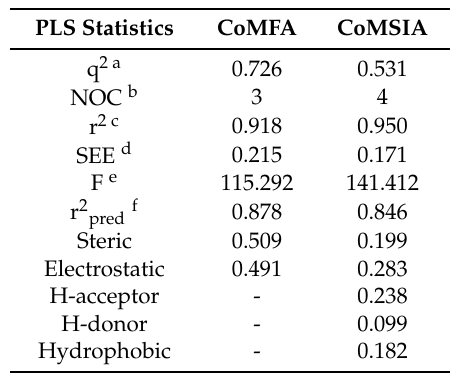
Table 2. The PLS statistical results of CoMFA and CoMSIA model.